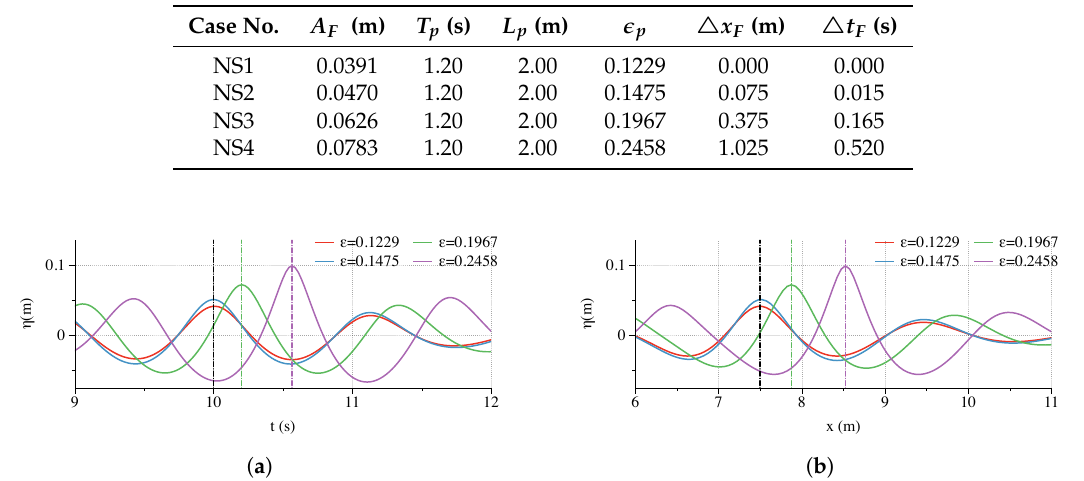
Figure 19. Comparison of wave surface elevations at the respective real focusing time and location with four different wave steepnesses ( a ) the time series at respective real focusing time, ( b ) the comparison of the wave profiles in the longitudinal direction at the respective real focusing locations.